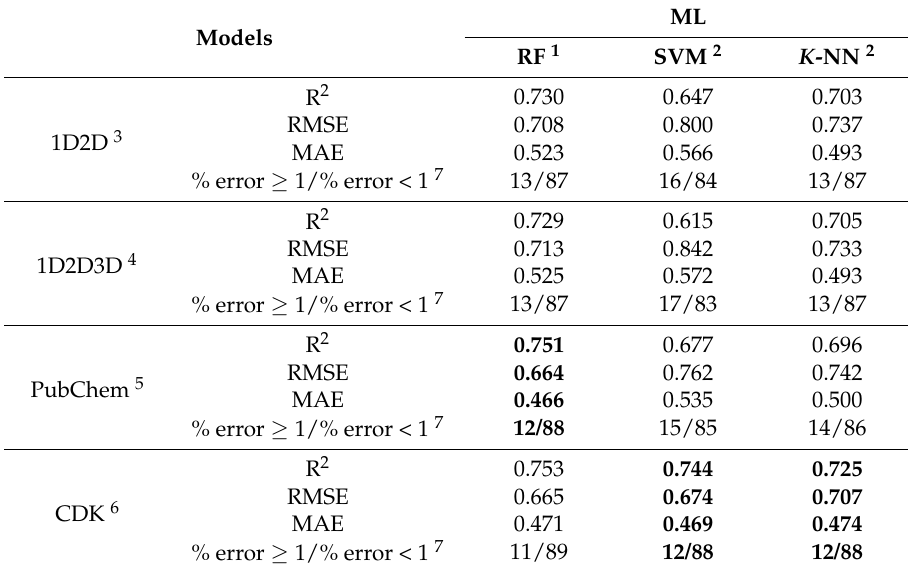
Table 4. Performance of different machine learning algorithms. The best models are highlighted in bold.